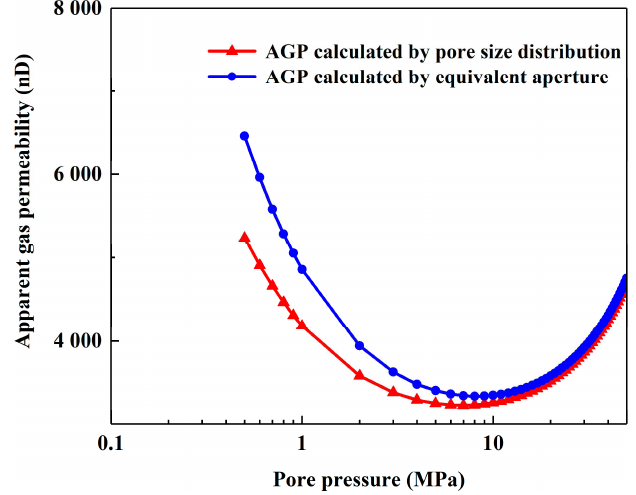
Figure 19. The AGP calculated by PSD and equivalent aperture ( S w = 0).